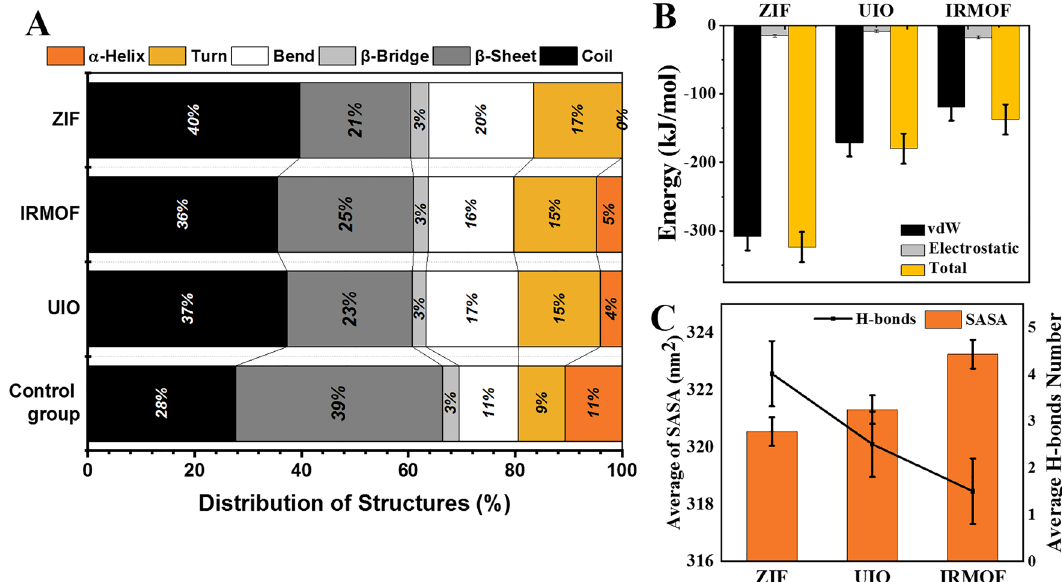
Figure 3. ( A ) Distribution of the spike protein secondary structures after interaction with MOFs. ( B ) Average vdW, the electrostatic and total energy of the spike protein and MOF interactions. ( C ) Average of contact area between SP and aqueous media after interacting with MOFs and average H-bonds between spike protein and